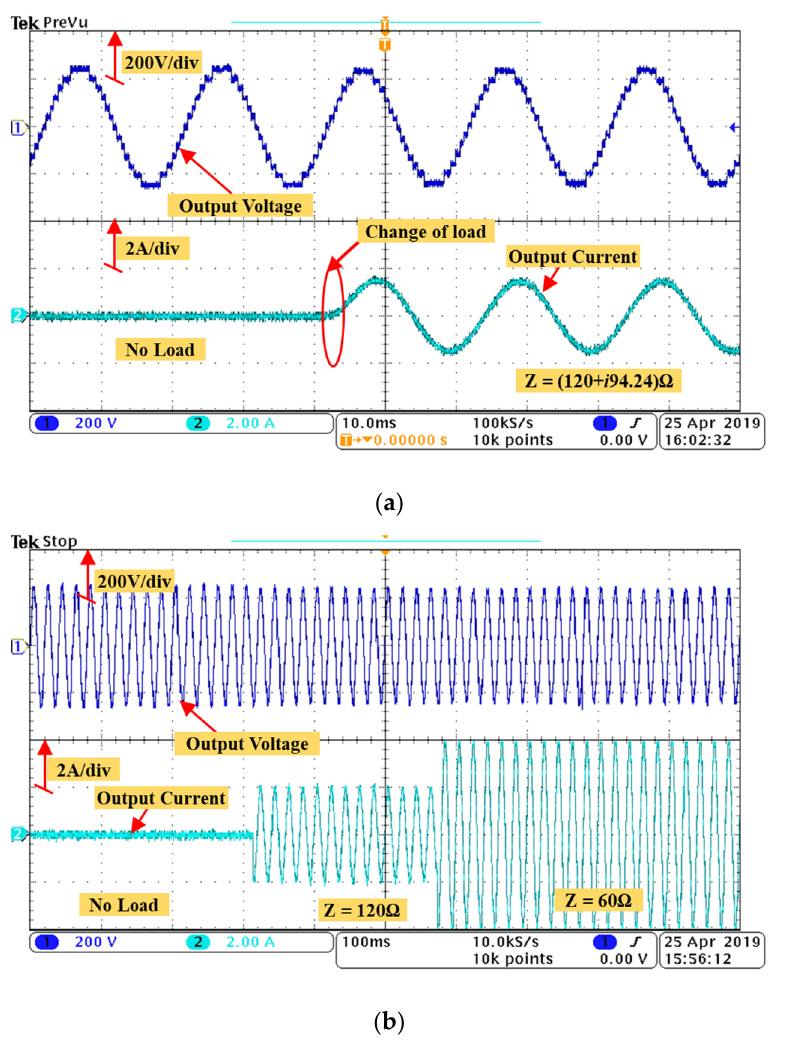
Figure 12. Terminal voltage and Load current for dynamic change in load with a change of load from ( a ) no-load to 60 ohm + 300 mH and ( b ) no-load to 120 ohm to 60 ohm.